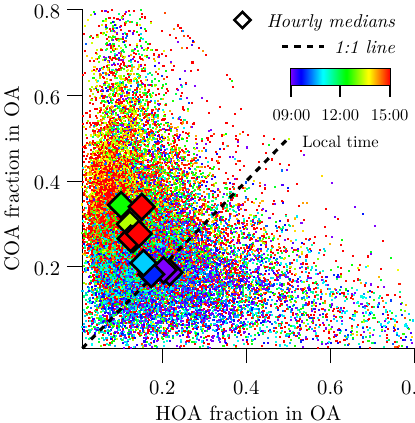
Figure 6. Diurnal shift of the source of primary OA from morning rush hour traffic to midday cooking activities. Dots show individual measurements and diamonds show hourly medians over the entire sampling campaign.